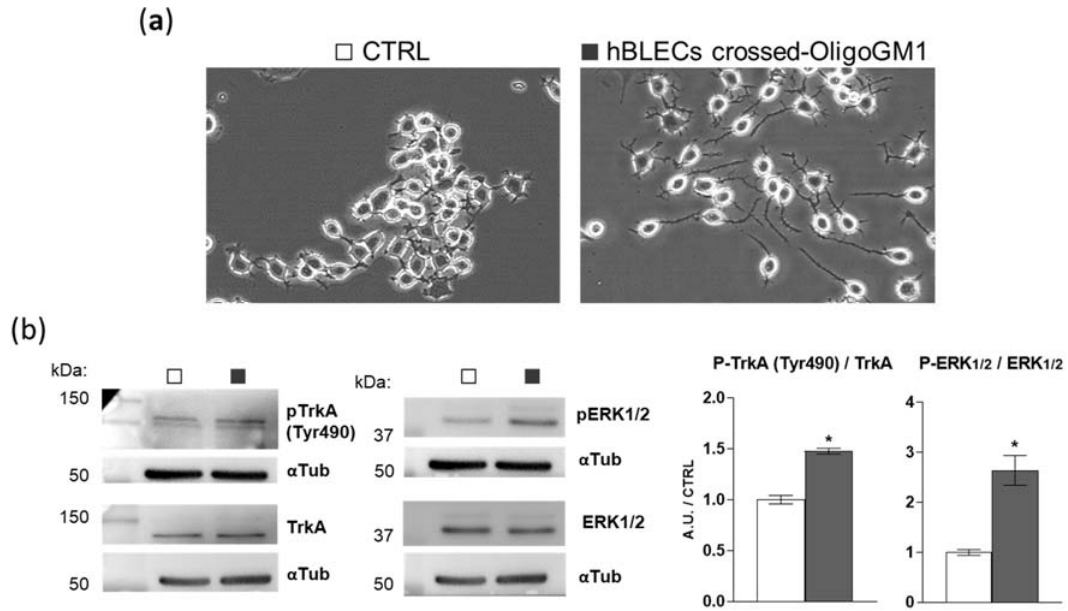
Figure 9. The biological activity of hBLEC-crossed OligoGM1. ( a ) E ff ect of hBLEC-crossed OligoGM1 on the morphology of N2a cells. After 24 h incubation, cells were analyzed with phase contrast microscopy with 200 × magnification. Images are representative of 4 independent experiments ( n = 4). N2a cells in the absence (CTRL, (cid:3) ) or in the presence of hBLEC-crossed OligoGM1 ( (cid:4) ). ( b ) E ff ect of hBLEC-crossed OligoGM1 on the TrkA-ERK1 / 2 pathway. Expression of TrkA, phosphorylated TrkA (pTrkA, tyrosine 490, Tyr490), total extracellular signal-regulated protein kinase 1 and 2 (ERK1 / 2), phosphorylated ERK1 / 2 (pERK1 / 2, Thr202 / Thr204), and α -tubulin ( α Tub) in cell lysate by means of specific antibodies and reveled by enhanced chemiluminescence. Left: immunoblotting images are shown. Right: semi-quantitative analysis of pTrkA, pERK1 / 2, TrkA, and ERK1 / 2 related to α -tubulin, used as internal normalizer. Data are expressed as the mean ± SEM of fold increase over control from 4 independent experiments (* p < 0.05, Mann–Whitney test, n = 4).